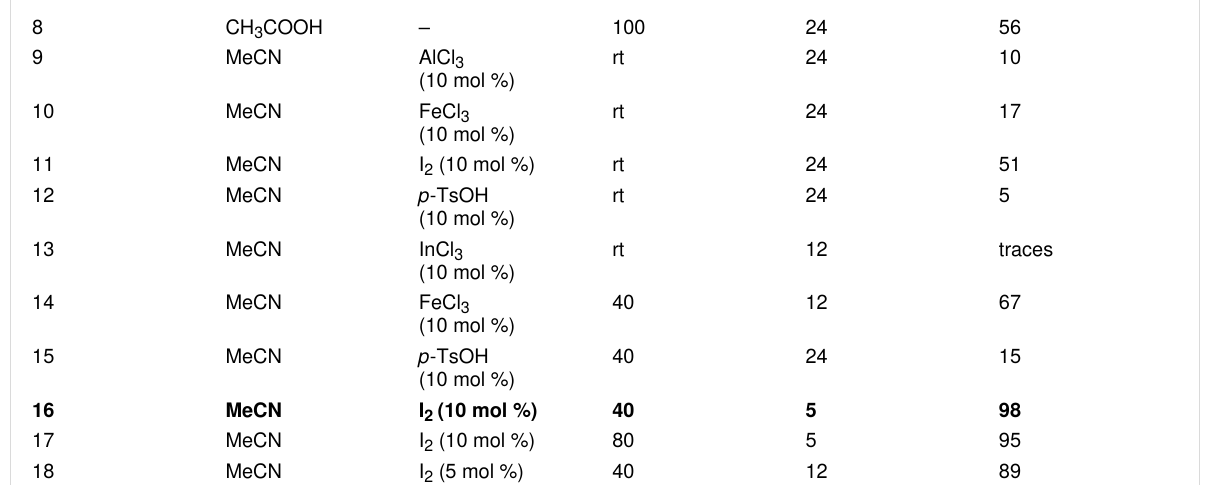
Table 1: Optimization of the reaction conditions for the preparation of 5-methoxy-3-(2,2,2-trifluoro-1-(1 H -indol-3-yl)-1-phenylethyl)-1 H -indole ( 3a ) a . (continued) 8